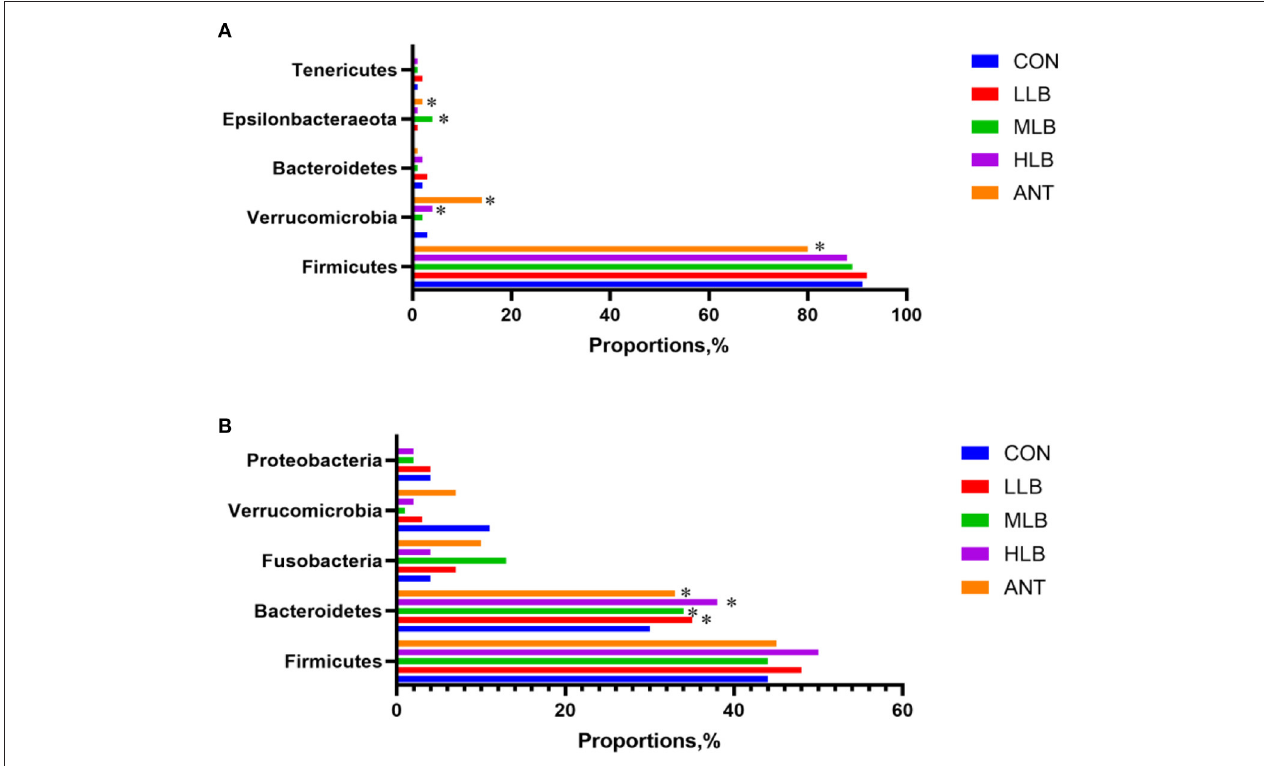
FIGURE 4 | Differences of intestinal microbiota in experimental groups at the phylum level, n = 6 for each group. (A) 21 d at the phylum level; (B) 42 d at the phylum level. CON, control group, basal diet; LLB, basal diet + 200 mg/kg B. licheniformis ; MLB, basal diet + 400 mg/kg B. licheniformis ; HLB, basal diet + 800 mg/kg B. licheniformis ; ANT, basal diet + 150 mg/kg aureomycin. * means significant difference compared with control ( P <